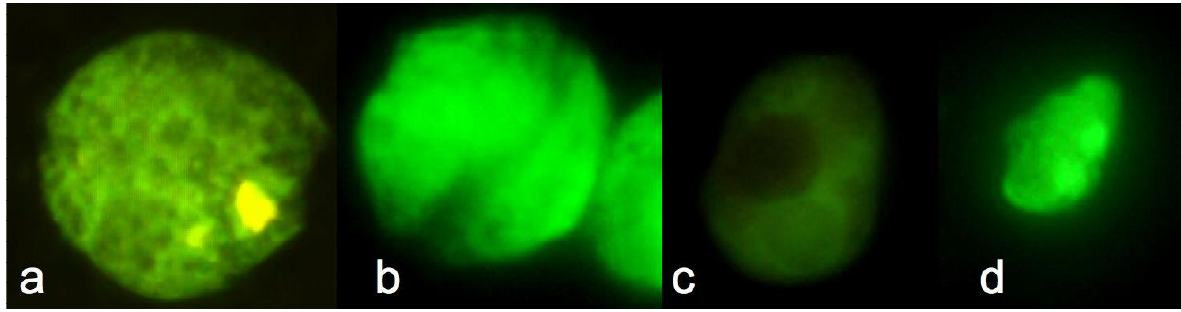
Figure 2. Signal enhancement using Tyramide Signal Amplification. (a) and (c) show a cell hybridized with a FITC-labeled probe: dinoflagellate species level probe and a cryptomonad clade level probe, respectively; (b) and (d) show the application of the same probe for a dinoflagellate and a cryptomonad with